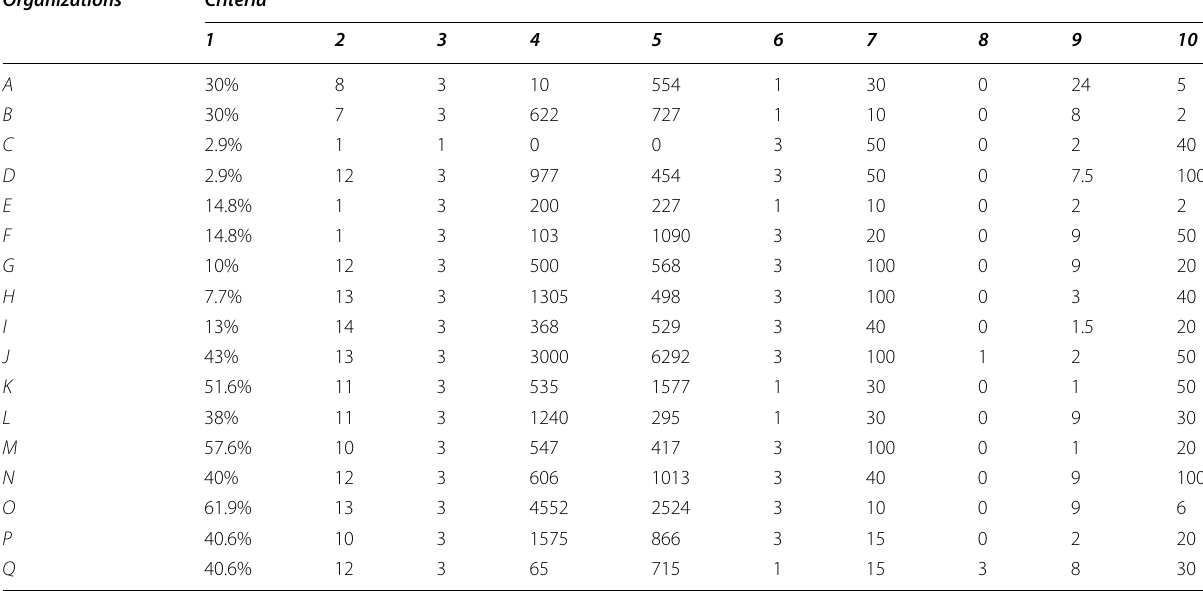
Table 2 Performance values of the 17 organizations of interest (i.e. alternatives) Organizations